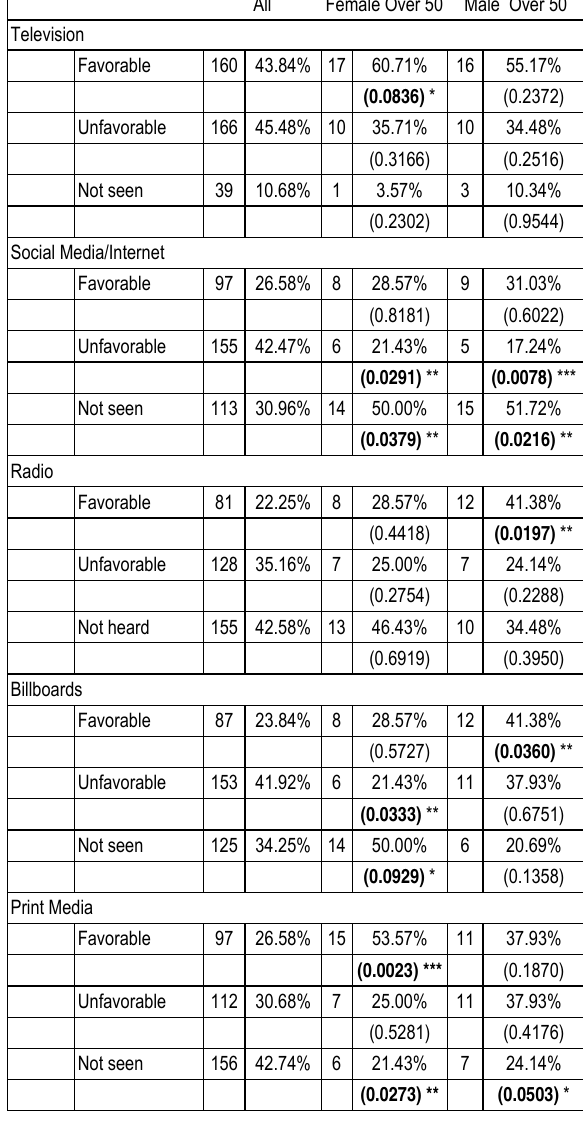
Table 3 (cont.). Compare male and female by age This table shows the overall results and the results by gender for specific age groups that had significant differences. The table shows the total number of respondents for each category per question and the percent. The number in the parenthesis is the probability that the percentage responses are statistically significantly different from the overall survey responses based on a Chi-square statistic. One aste- risk indicates significance at the 10% level, two asterisks at the 5% level and 3 asterisks within the 1%